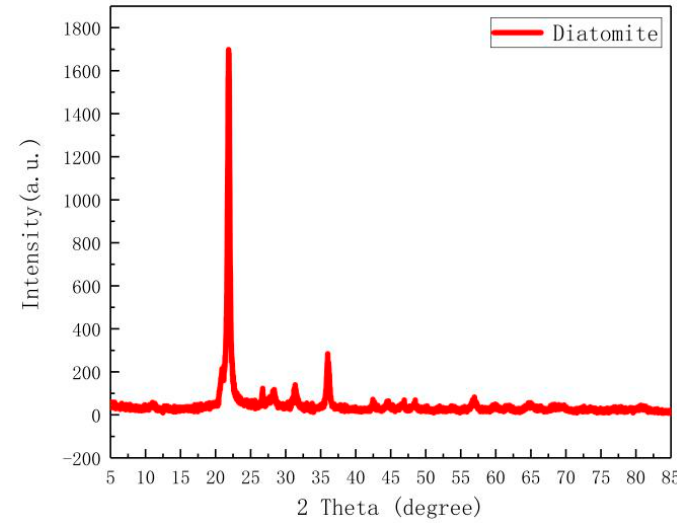
Figure 2. X-ray di ff raction patterns (XRD) patterns of pure Figure 2. X-ray diffraction patterns (XRD) patterns of pure diatomite.